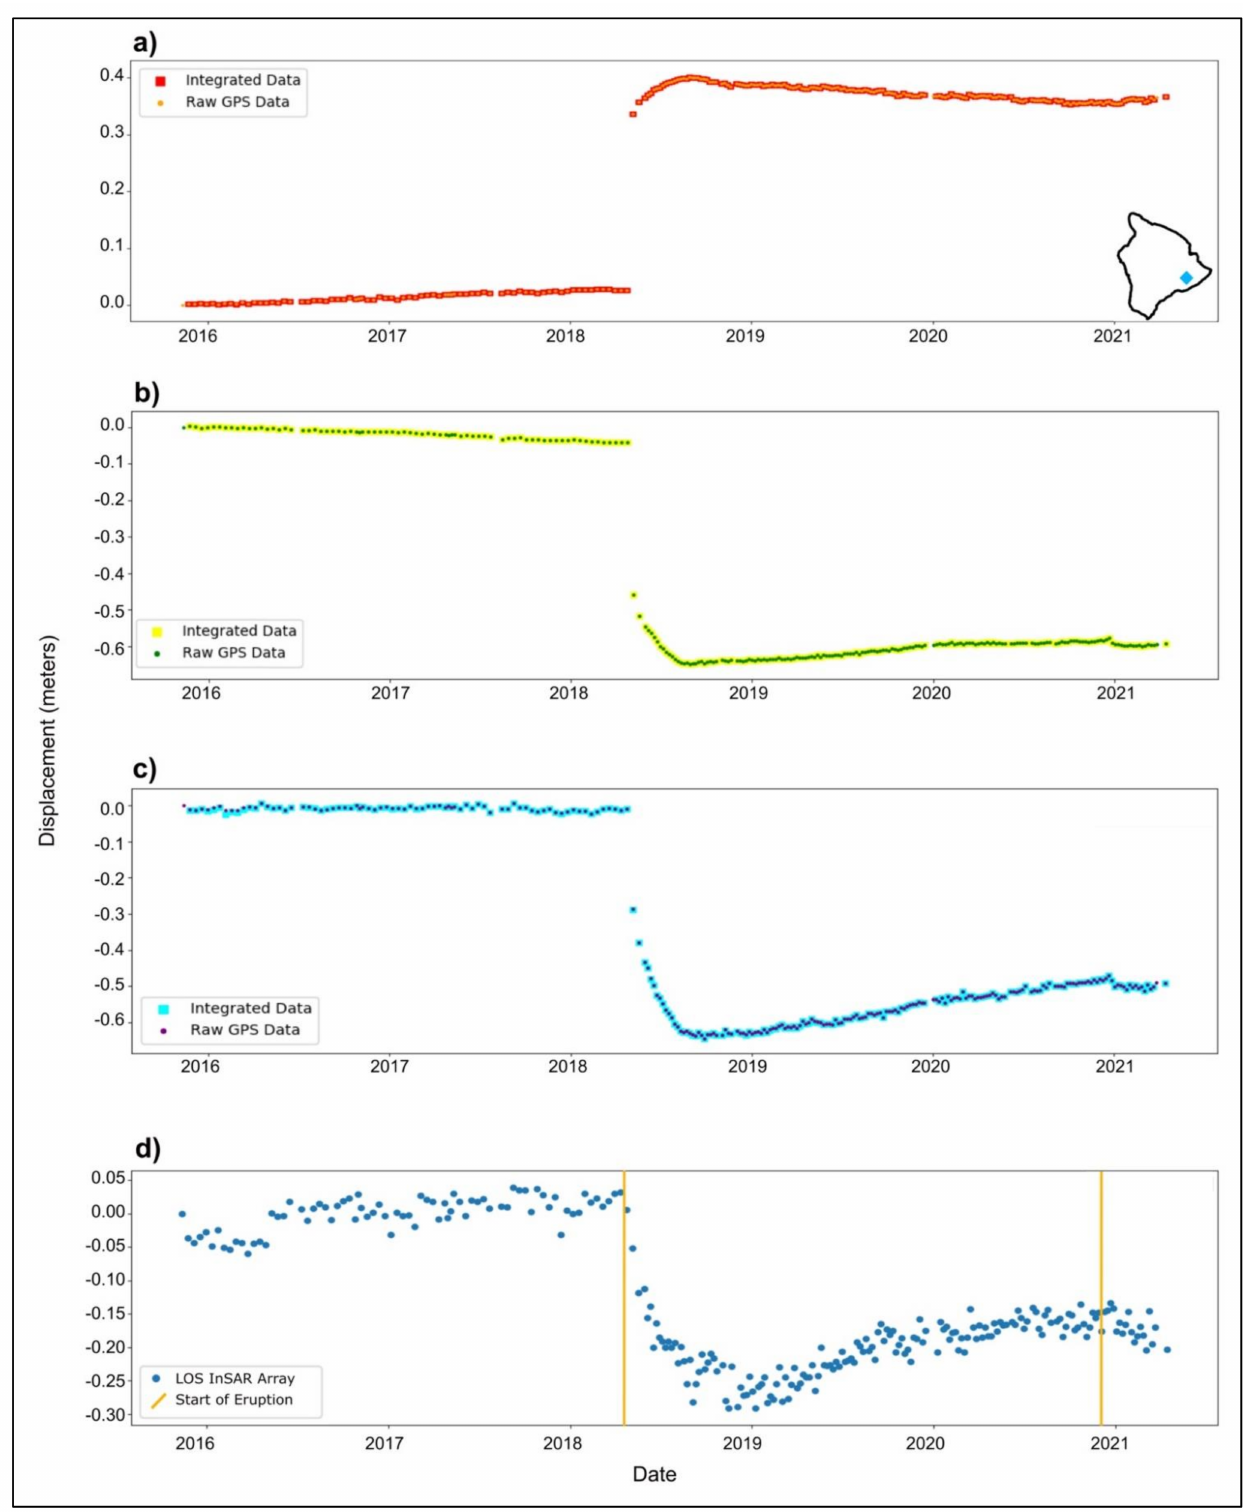
Figure 9. Integrated results compared to original, raw GNSS time series in the ( a ) east-, ( b ) north-, and ( c ) up-components of motion at NUPM GNSS station (19.385 ◦ N, –155.175 ◦ W). ( d ) DInSAR LOS time series at the same pixel, over NUPM station. Results clearly distinguish the Mw 6.9 earthquake rupture in 2018 and continued motion due to volcanic activity. Yellow lines are as in Figure 8, above. The inset in subfigure ( a ) shows location of NUPM station in